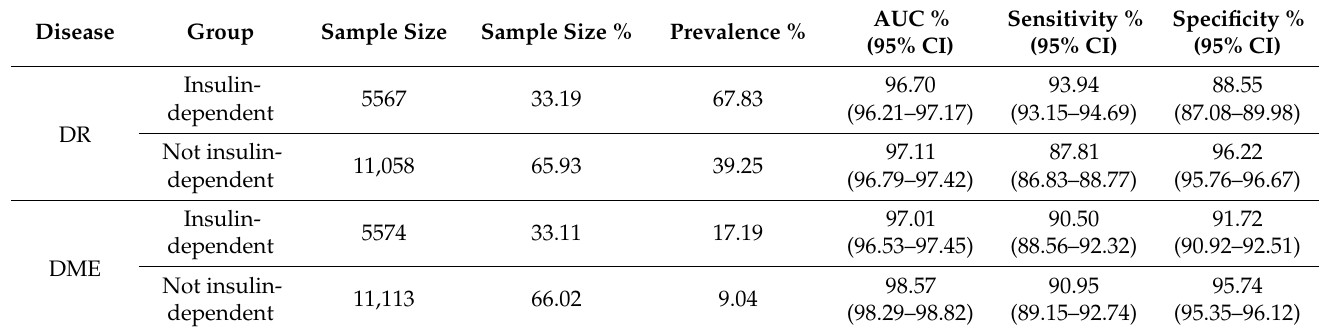
Table A4. Stratification results for the detection of referable retinopathy and diabetic macular edema on the patient level for insulin